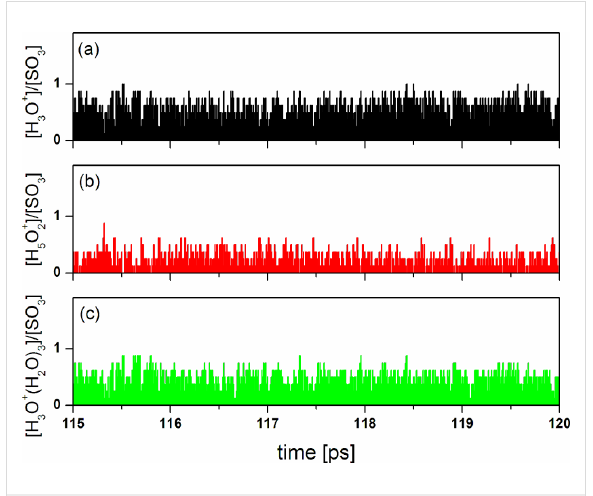
Figure 14: A 5-ps section of a QMD trajectory showing the change in the relative content of different hydrated proton complexes at λ = 10. This short time section is chosen for visibility, but the behavior shown here is typical of any time section from the same trajectory.